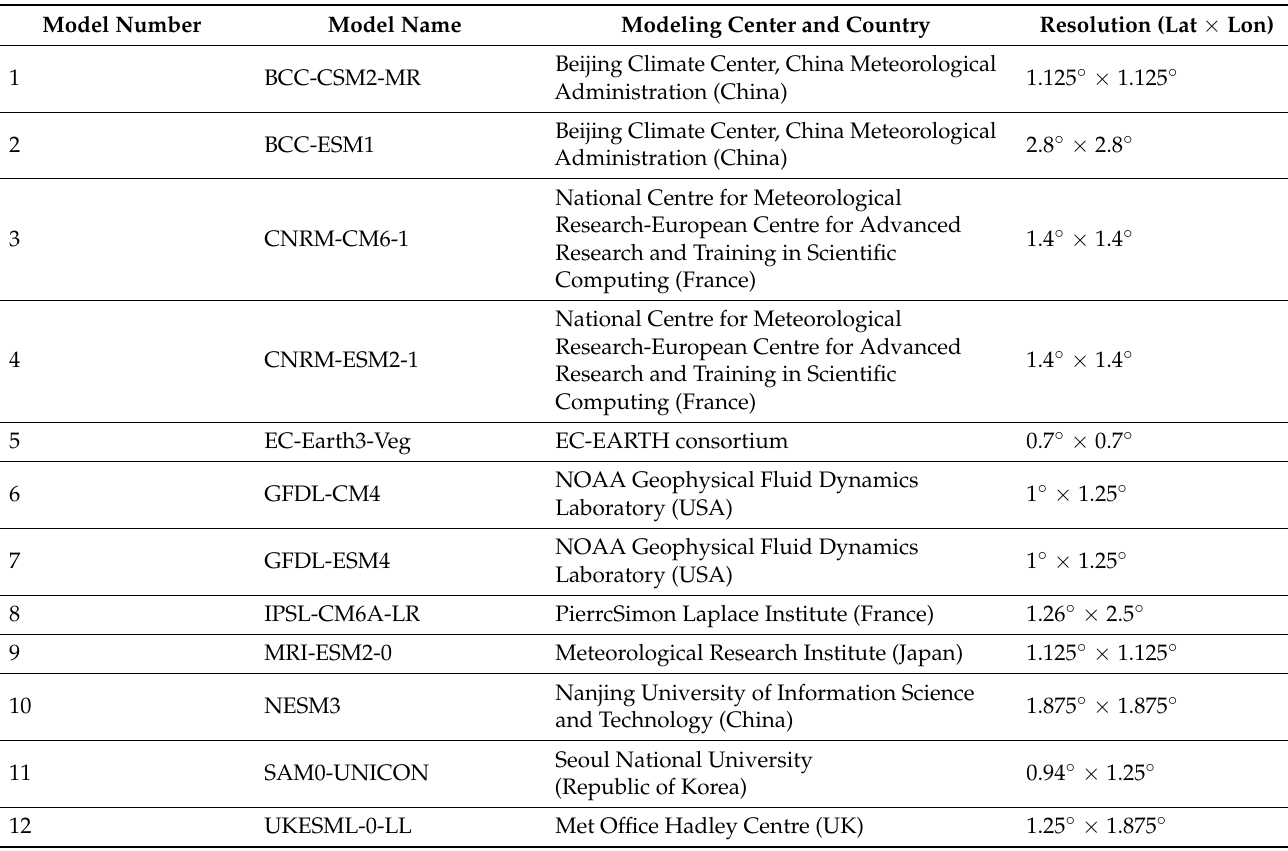
Table 1. Information of 12 global climate models in